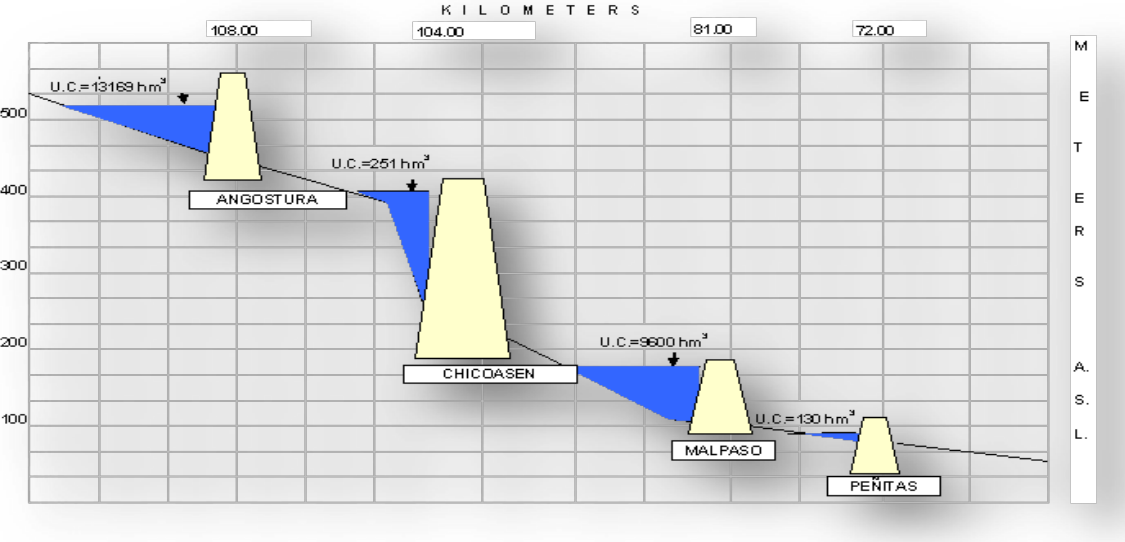
Figure 3. Storage capacity of the dams of the Grijalva River system [25] .